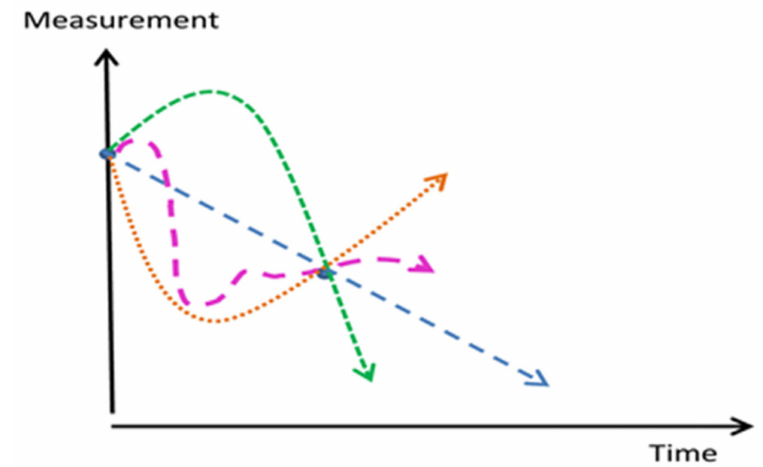
Figure 3. Most follow-up or intervention studies apply one baseline measurement and a single follow-up determination. If the follow-up point is lower than the baseline point, this is usually interpreted as a decline, although in reality one cannot know whether it represents a measurement on a di ff erent course, which may even be an opposite one. Three potential courses are indicated (dotted green, orange, and purple lines) (with permission from reference